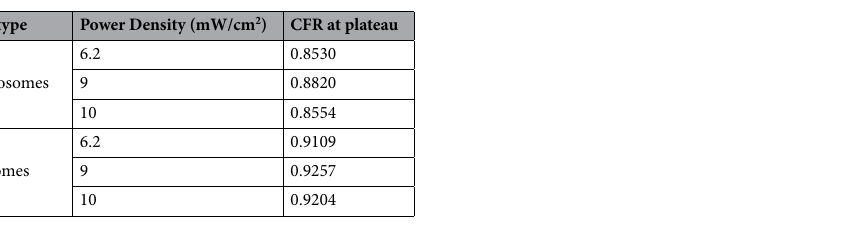
Table 2. Summary of release results for calcein